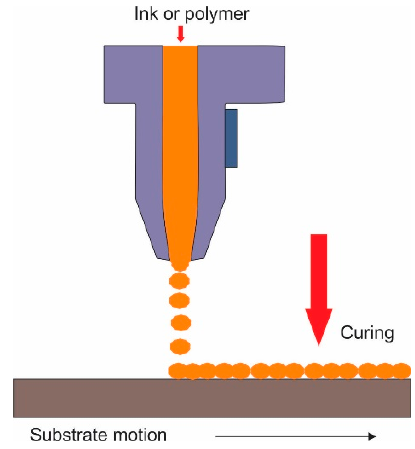
Figure 5. Basic illustration of direct printing procedure.